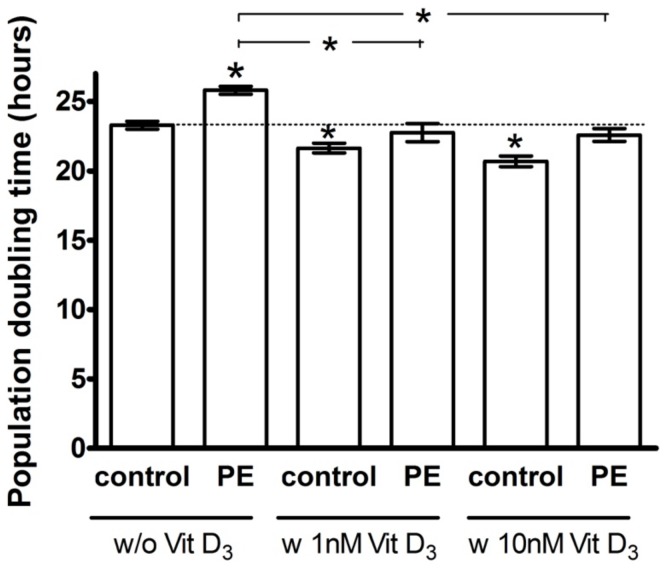
Effect of pregnancy outcome and 1,25(OH)2 vitamin D3 on ECFC population doubling time.ECFCs of uncomplicated (control) and preeclamptic (PE) pregnancies were incubated in the presence and absence of 1,25(OH)2 vitamin D3 (1 nM or 10 nM) in EGM +8% (v/v) FBS. Cell numbers were counted and population doubling time calculated after 72 h. Population doubling time was significantly longer in PE ECFCs compared to uncomplicated pregnancy (control) in the absence of supplemental vitamin D (P<0.05). PE population doubling time was reduced to control levels by vitamin D, n = 8. *P<0.05 vs. untreated control or (as indicated by horizontal lines above the vertical bars) vs. untreated PE for 1,25(OH)2 vitamin D3 effects.